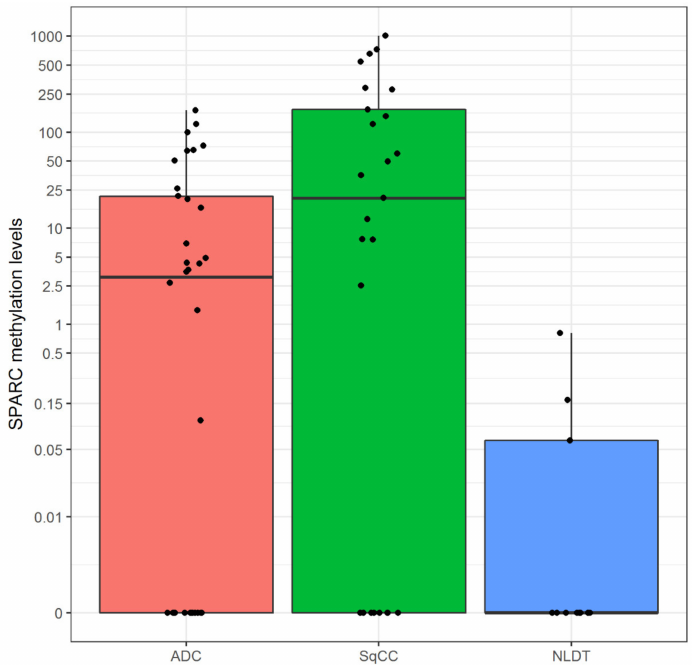
Figure 3. Boxplots of global SPARC promoter methylation among the three phonotypical groups (pink for ADC, green for SqCC and blue for NLDT). The following five number summaries were reported into each box plot: minimum, first quartile, median, third quartile, and maximum. The central rectangle spans the first quartile to the third quartile (i.e., the interquartile range or IQR). The segment inside the rectangle shows the median and “whiskers” (above and below each box) show the locations of the minimum and